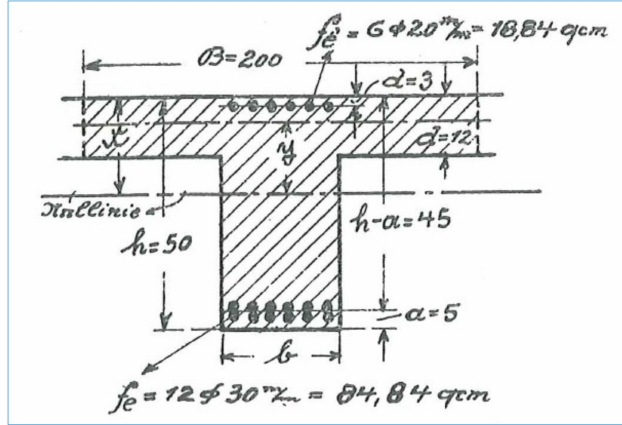
Figure 12. A view of historical structures reinforcement. [33].